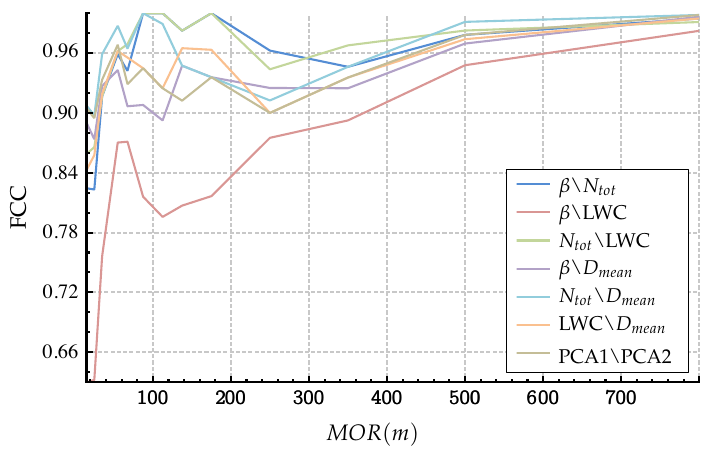
Figure 9. Fog correlation coefficient according to the MOR